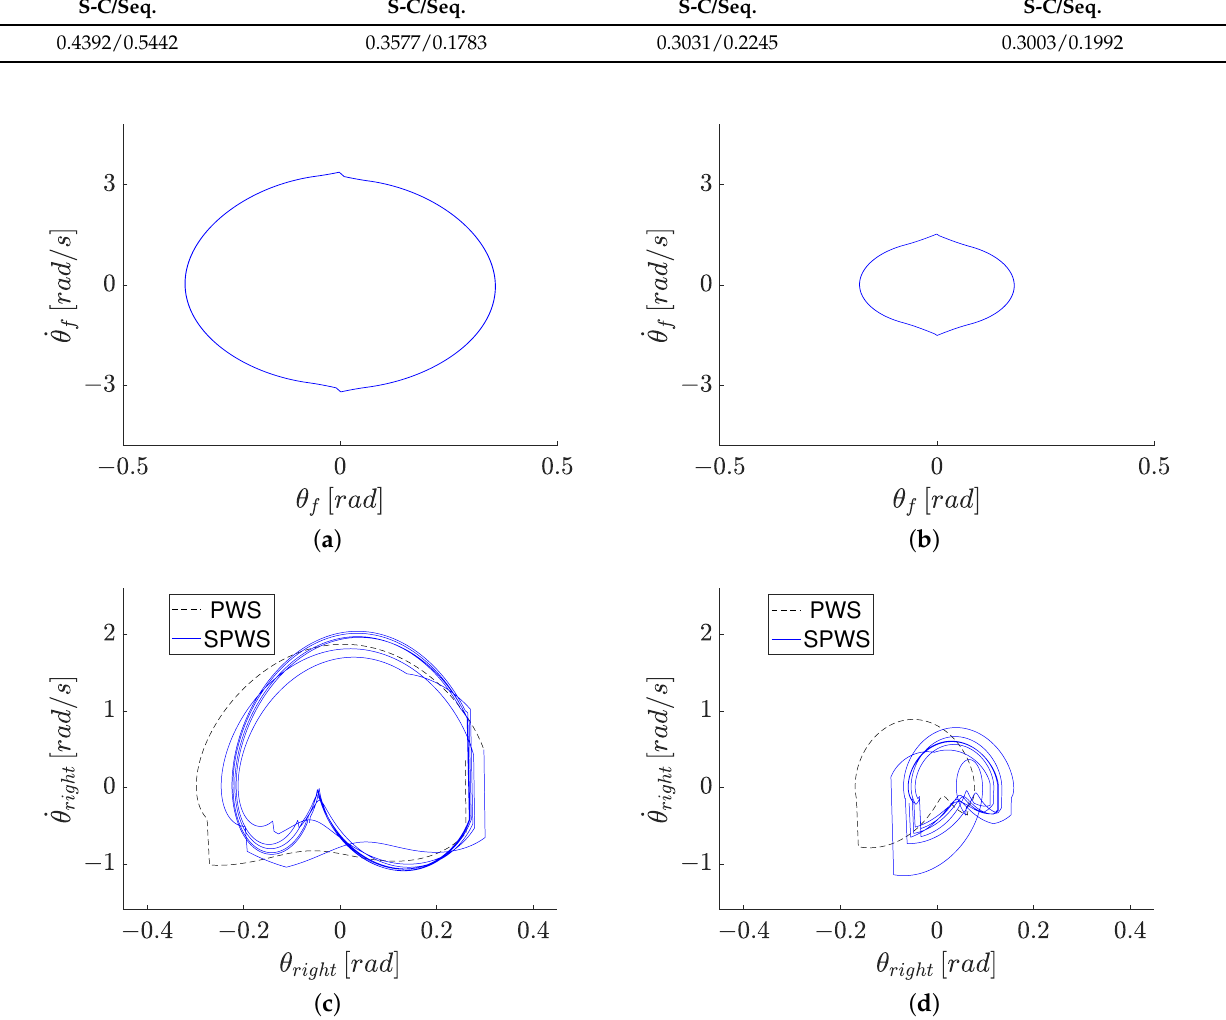
Figure 7. Dynamic behavior of the best solutions of S-C and sequential design processes. Limit cycle of frontal plane dynamics: ( a ) S-C design. ( b ) Sequential design. PWS and SPWS limit cycles of the sagittal plane (right leg of SPBR): ( c ) S-C design. ( d ) Sequential